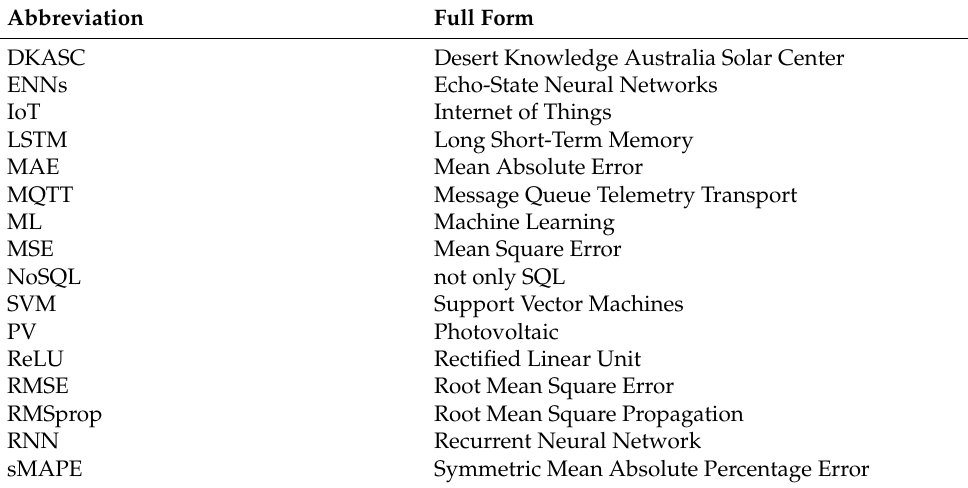
Table 1. List of